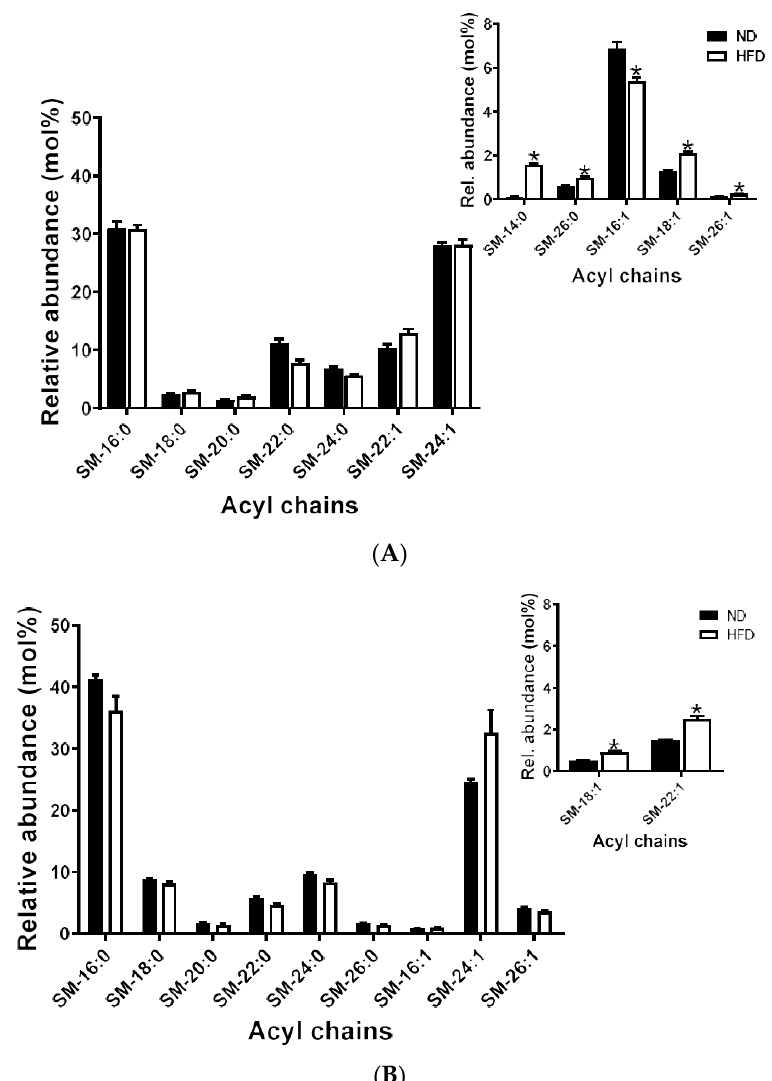
Figure 6. ( A ) Plasma sphingomyelin (SM) species detected; inset shows species with low relative abundance. Data are expressed as means ± SEM, * p < 0.05. Asterisks indicate a significant difference compared to the matched ND value. ( B ) Meibum sphingomyelin species detected; inset shows species with low relative abundance. Data are expressed as means ± SEM, * p < 0.05. Asterisks indicate a significant difference compared to the matched ND value.